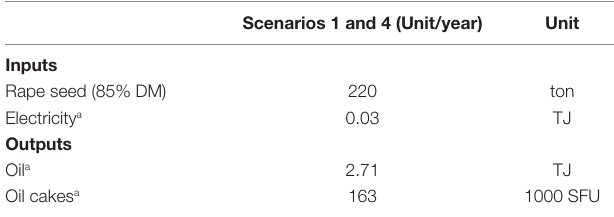
TaBle 6 | inputs and outputs from the vegetable oil production process for the entire system of 1000